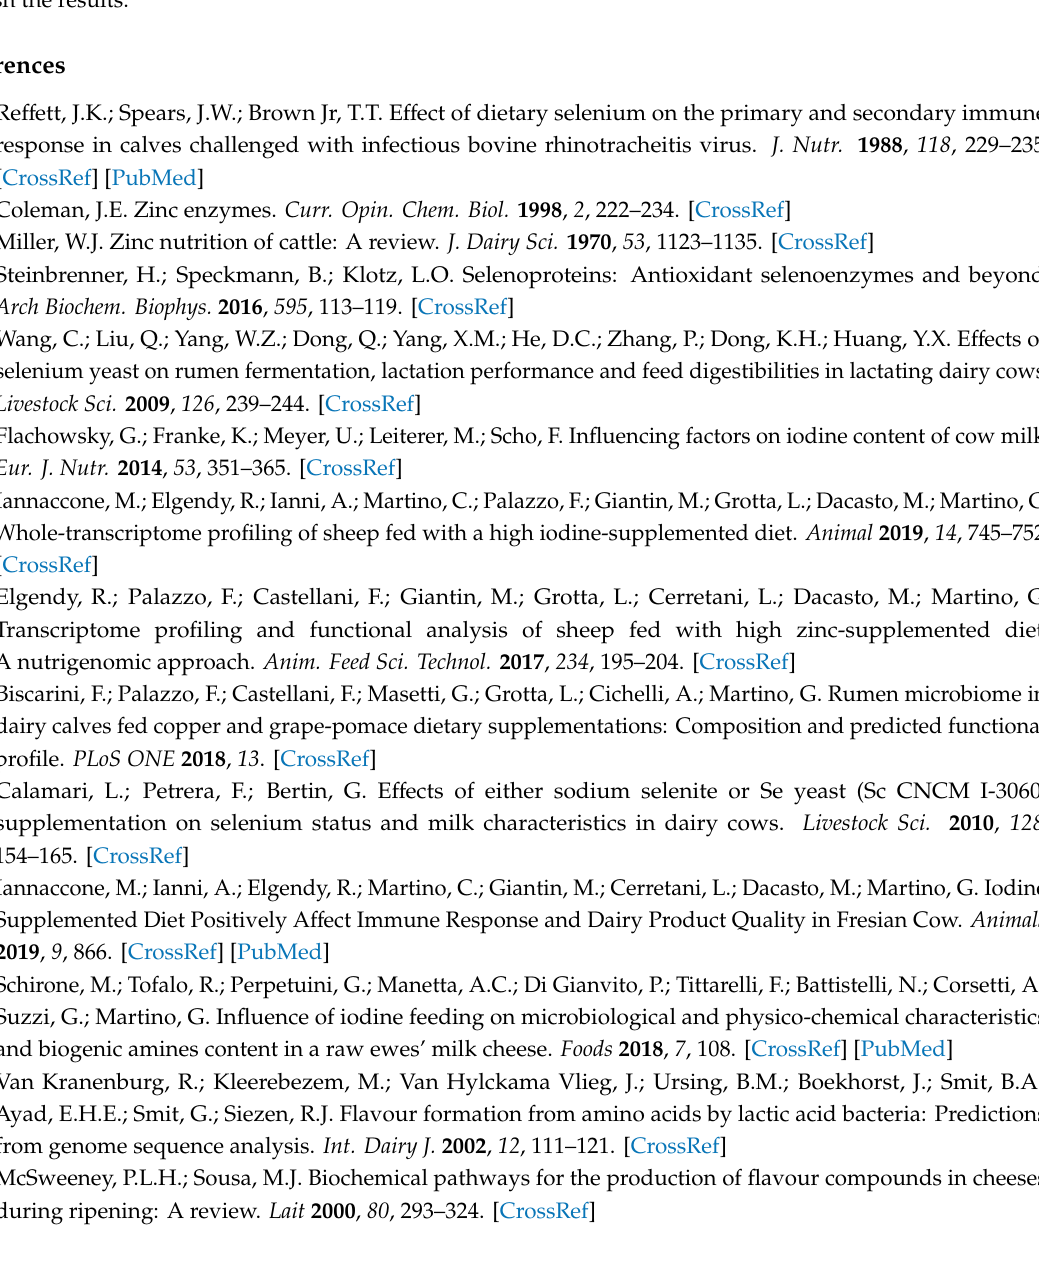
Table S1: Chemical composition of fresh (T 7 ) and 120-days ripened (T 120 ) Caciocavallo cheese obtained from lactating dairy cows fed control diet (CG) and control diet supplemented with zinc (ZG), selenium (SG), and iodine (IG). Table S2: Ingredients and chemical composition of complete diets administered to lactating dairy cows belonging to control group (CG), zinc group (ZG), selenium group (SG), and iodine group